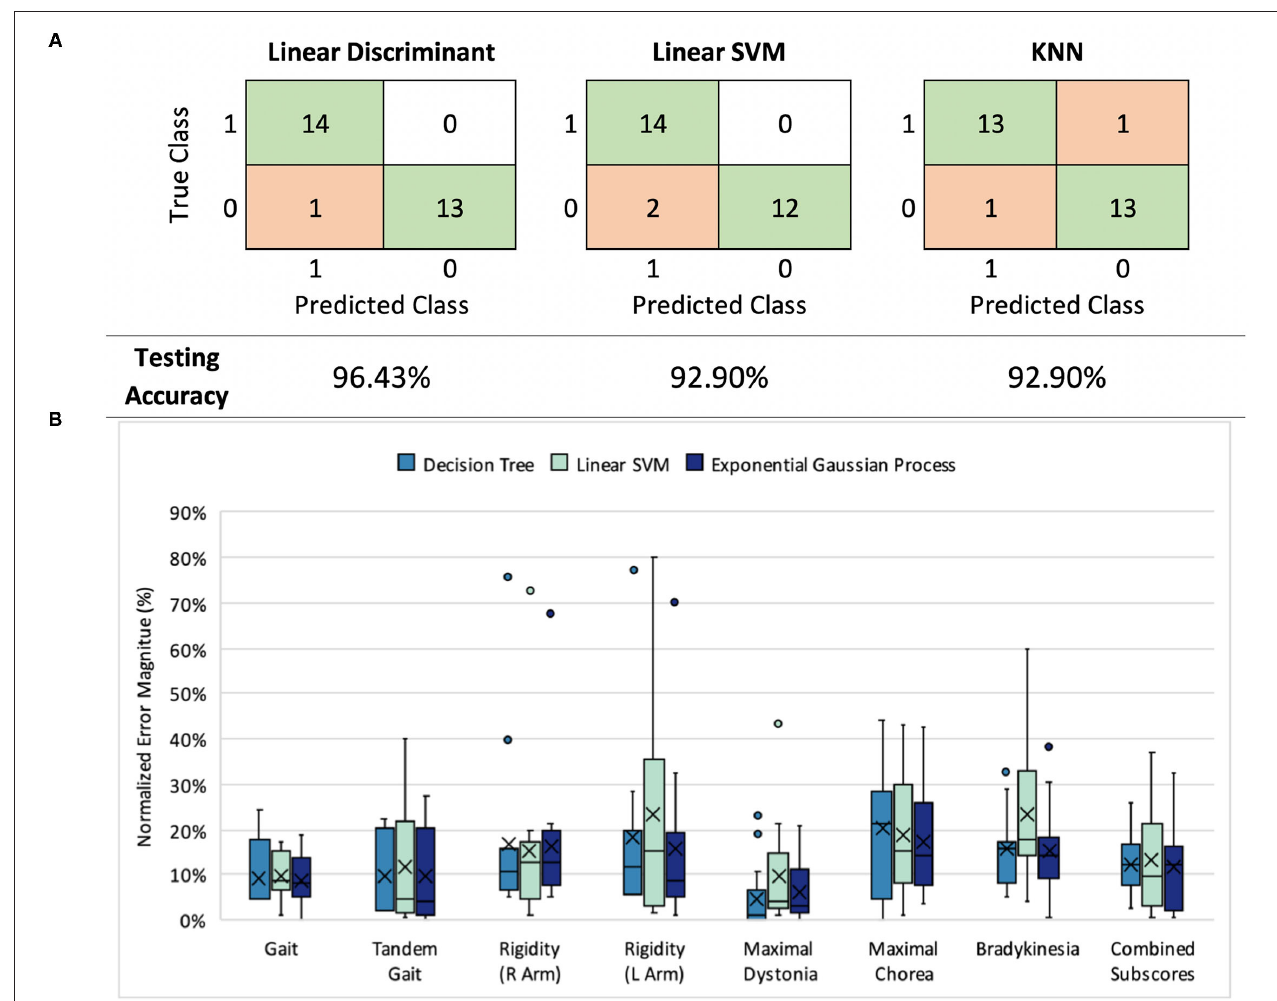
FIGURE 2 | (A) Classification results: model performance comparison (healthy controls = 0, symptomatic HD participants = 1) (B) UHDRS subscore prediction: normalized mean absolute error (nMAE) in predicted score for decision tree, linear SVM, and Gaussian process models in 7 UHDRS subscores and composite subscore. Boxplots indicate the 75% interquartile interval (box), median (solid line), mean (x), maximum and minimum values excluding outliers (whiskers), and individual errors